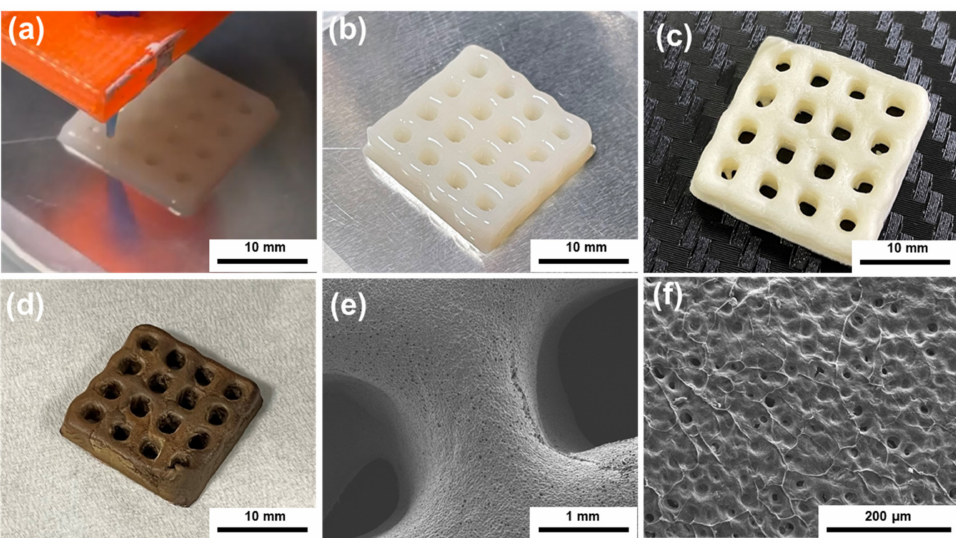
Figure 3. Performance of the PAAS/CNC ink for DIW. ( a ) The printing process. ( b ) The printed mesh structure. ( c ) The printed mesh after freeze-drying ( d ). The printed mesh after thermal imidization. ( e , f ) SEM images of the mesh after thermal imidization under different